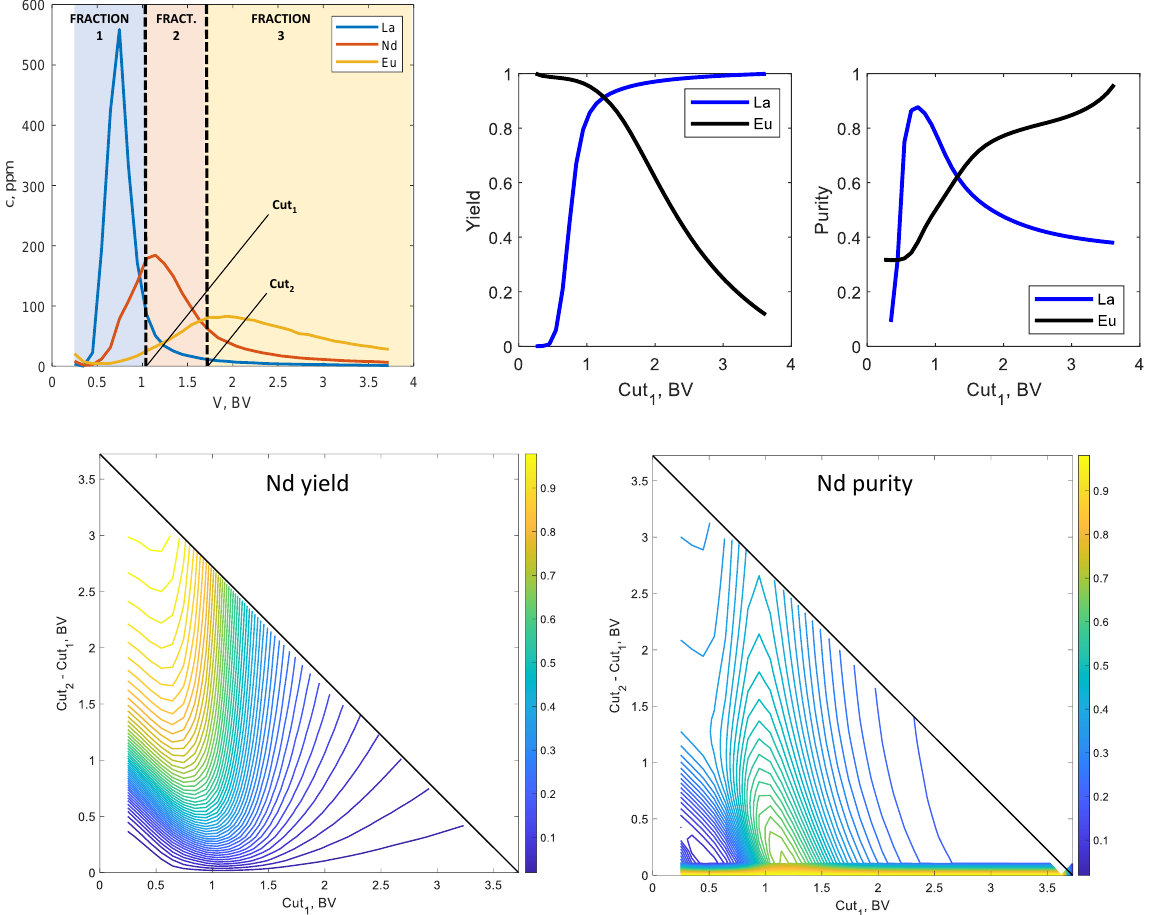
Figure 12. Effect of fractionation cut times on purity and yield of each REE (Resin = IRA-410; T = 298 ± 2 K; flowrate = 2.98 BV/h; Feed solution = #3; Feed volume = 0.025 BV; Acid concentration = 10 mM).